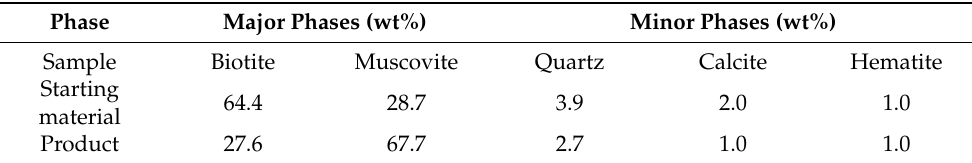
Table A1. Major and minor phases in the starting material and synthesized product.